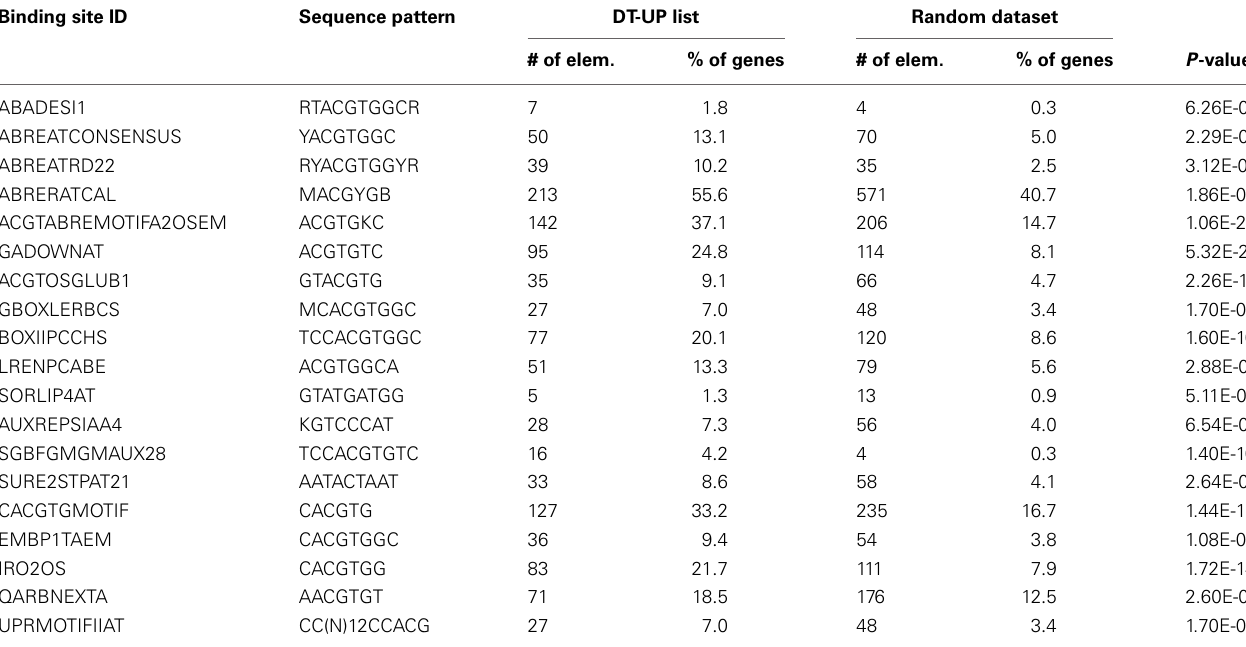
Promoter enrichment analysis of 382 up-regulated genes from the desiccome (DT-UP list, Figure 1 ) using 1.5Kb promoter regions upstream of the translational start. DNA motifs were counted using PLACE database resource (http://www.dna.affrc.go.jp/PLACE/signalup.html).#, mumber of cis-elements in the indicated data sets.